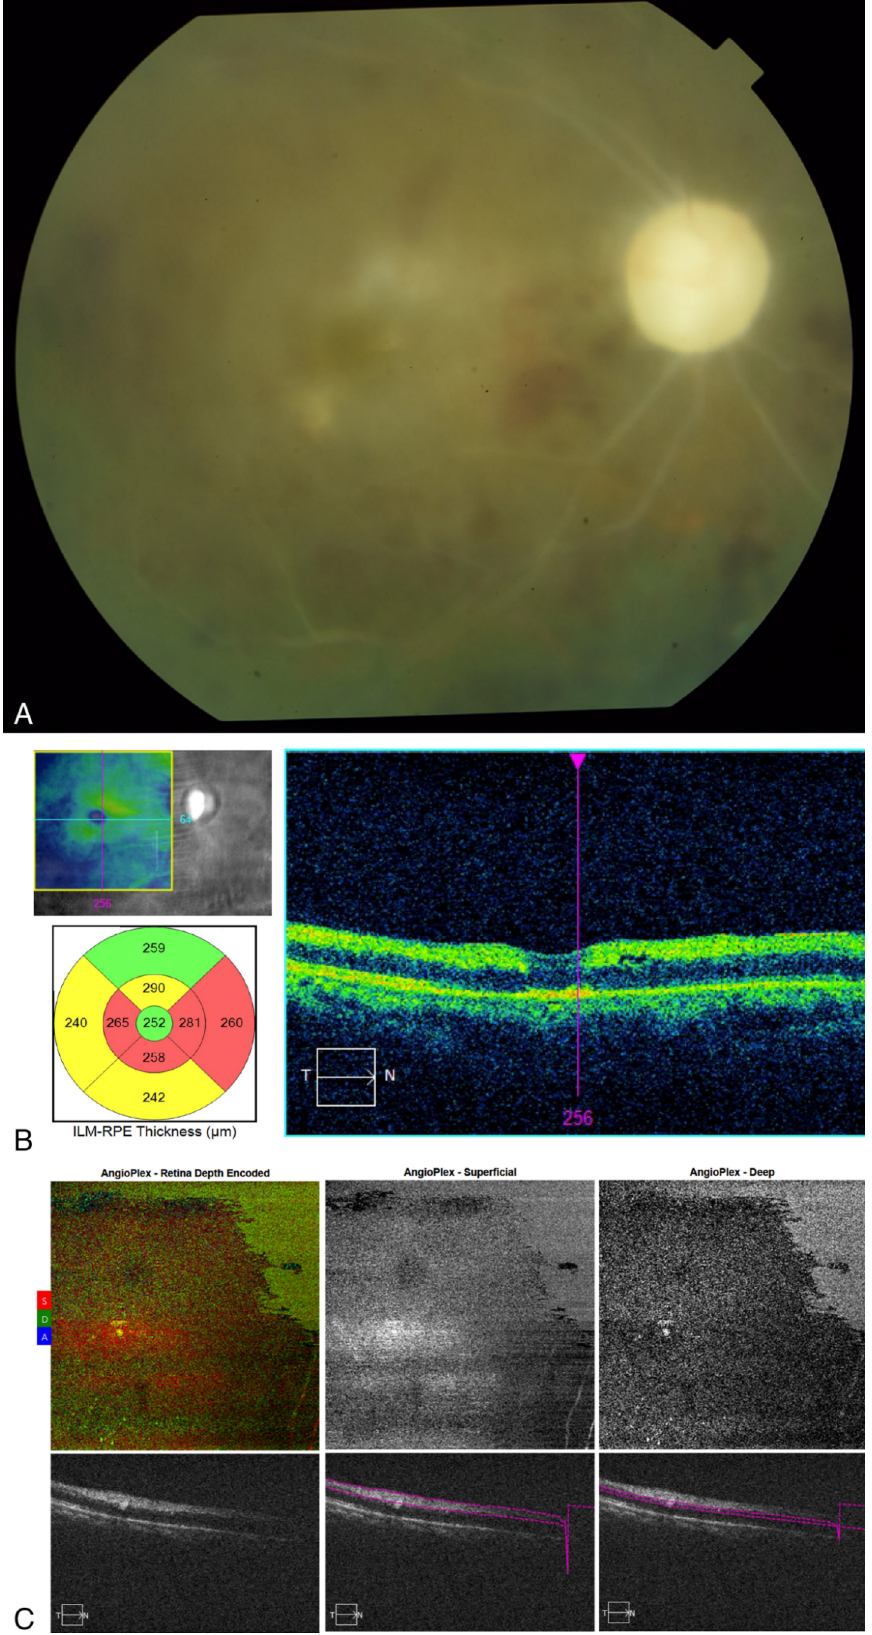
Figure 6: Multimodal imaging after 3 months of treatment; (A) fundus photograph showing optic atrophy and sclerosis of all retinal vessels with residual intraretinal hemorrhages; (B) optical coherence tomography scan showing generalized retinal atrophy more prominent in the inner retinal layers; (C) optical coherence tomography angiography showing absence of blood flow within the retinal vessels in both the superficial and deep capillary